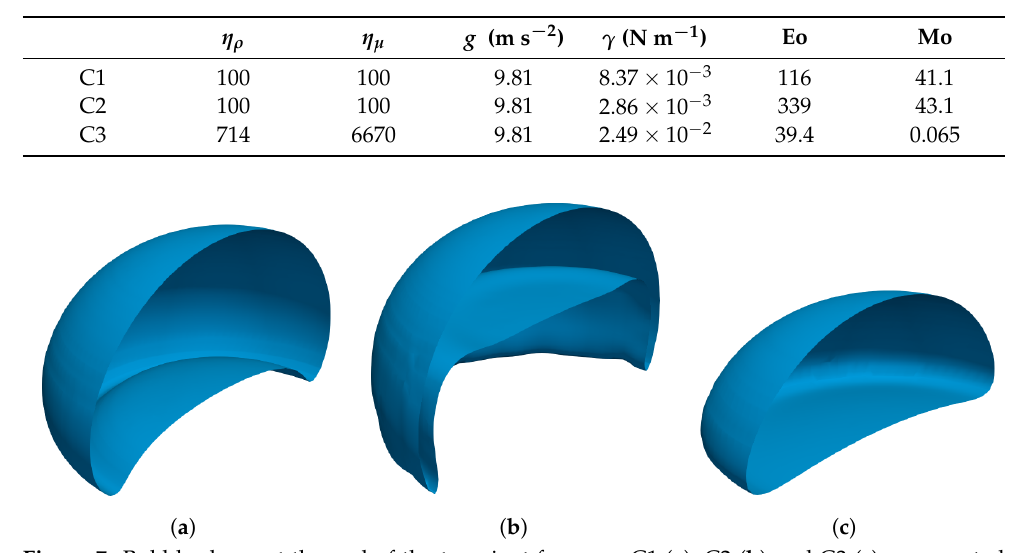
Table 7. Parameters for the 3D rising bubble test.